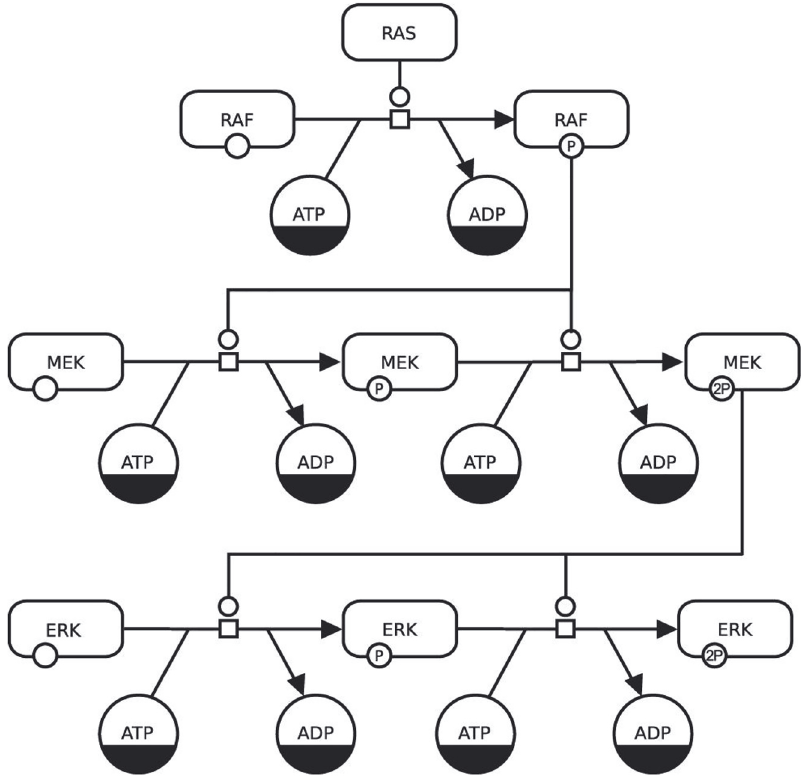
Figure 3: Design considerations for representing systems biology information with SBGN: an example of a SBGN PD (process description) map using two types of entity pool nodes; one for pools of different macromolecules and another for pools of simple chemicals ( © 2019–2022 Schreiber et al., CC BY 4.0